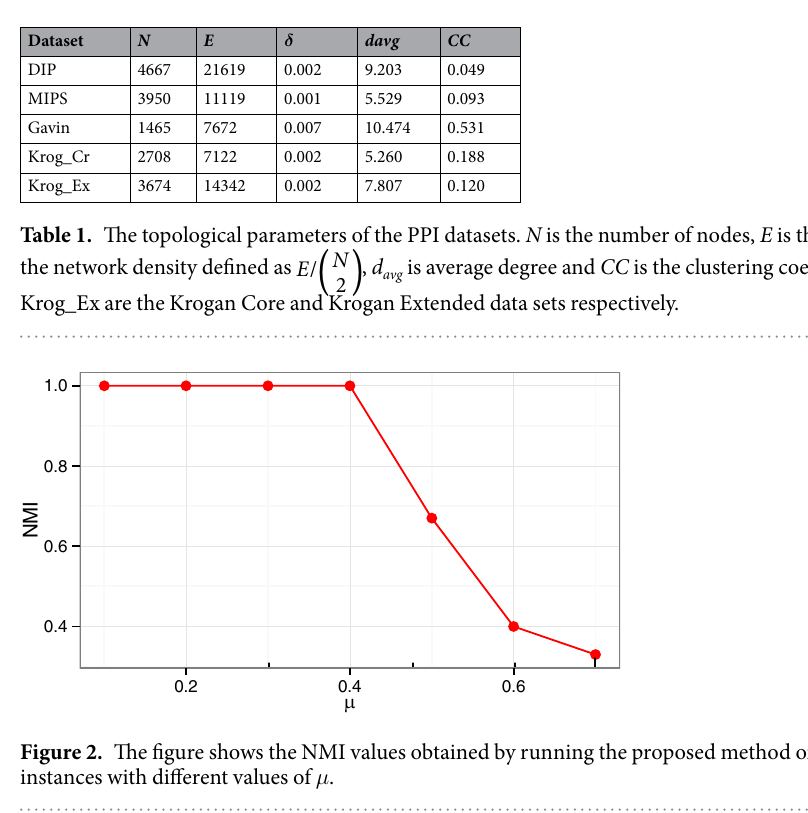
vertices each. The inter-module edges of GN model is controlled by the mixing parameter μ . In other words, the mixing parameter μ controls how well the modules are defined by controlling the number of edges with which a module is connected to the rest of the graph. When the value of μ is strictly less than 0.5, the expected number of links joining a node to others in different groups is less than those in the same group. This yields well defined groups (modules). As the value of μ drops to 0.5 or below, it becomes difficult to identify a module boundary from the rest of the network. Irrespective of the size and sparsity of the networks, GN benchmark dataset is a popular choice to test the correctness of different module detection algorithms and compare their performances. By varying the value of μ we generate networks with well defined modules as well as the networks with modules that are not so clearly distinguishable from the rest of the network. The later is a case similar to real life scenarios where all modules are not necessarily well defined. The code to generate the GN networks are freely available at the site https://sites.google.com/site/santofortunato/inthepress2. Further we use real life yeast PPI networks - two experimental yeast PPI datasets (Gavin et al . 22 , Krogan